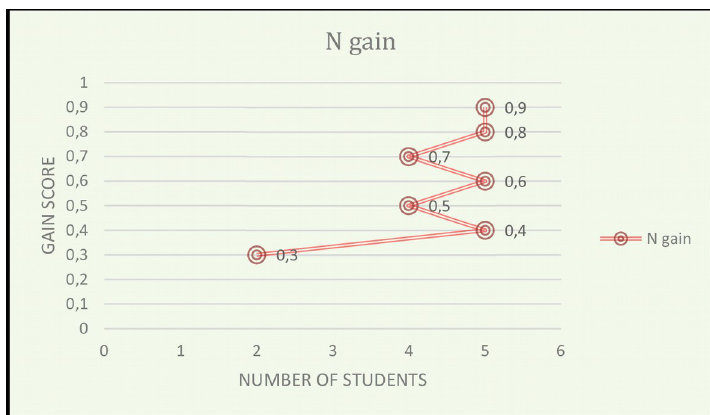
Figure 15. Gain score of students